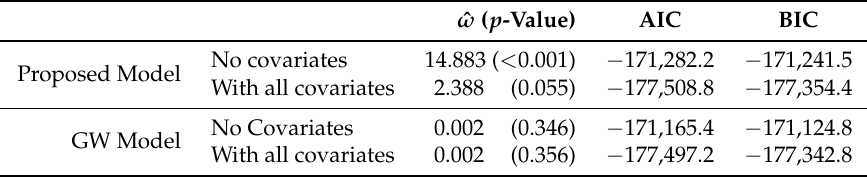
Table 2. Estimated dependence from Sarmanov-Beta models and goodness of fit